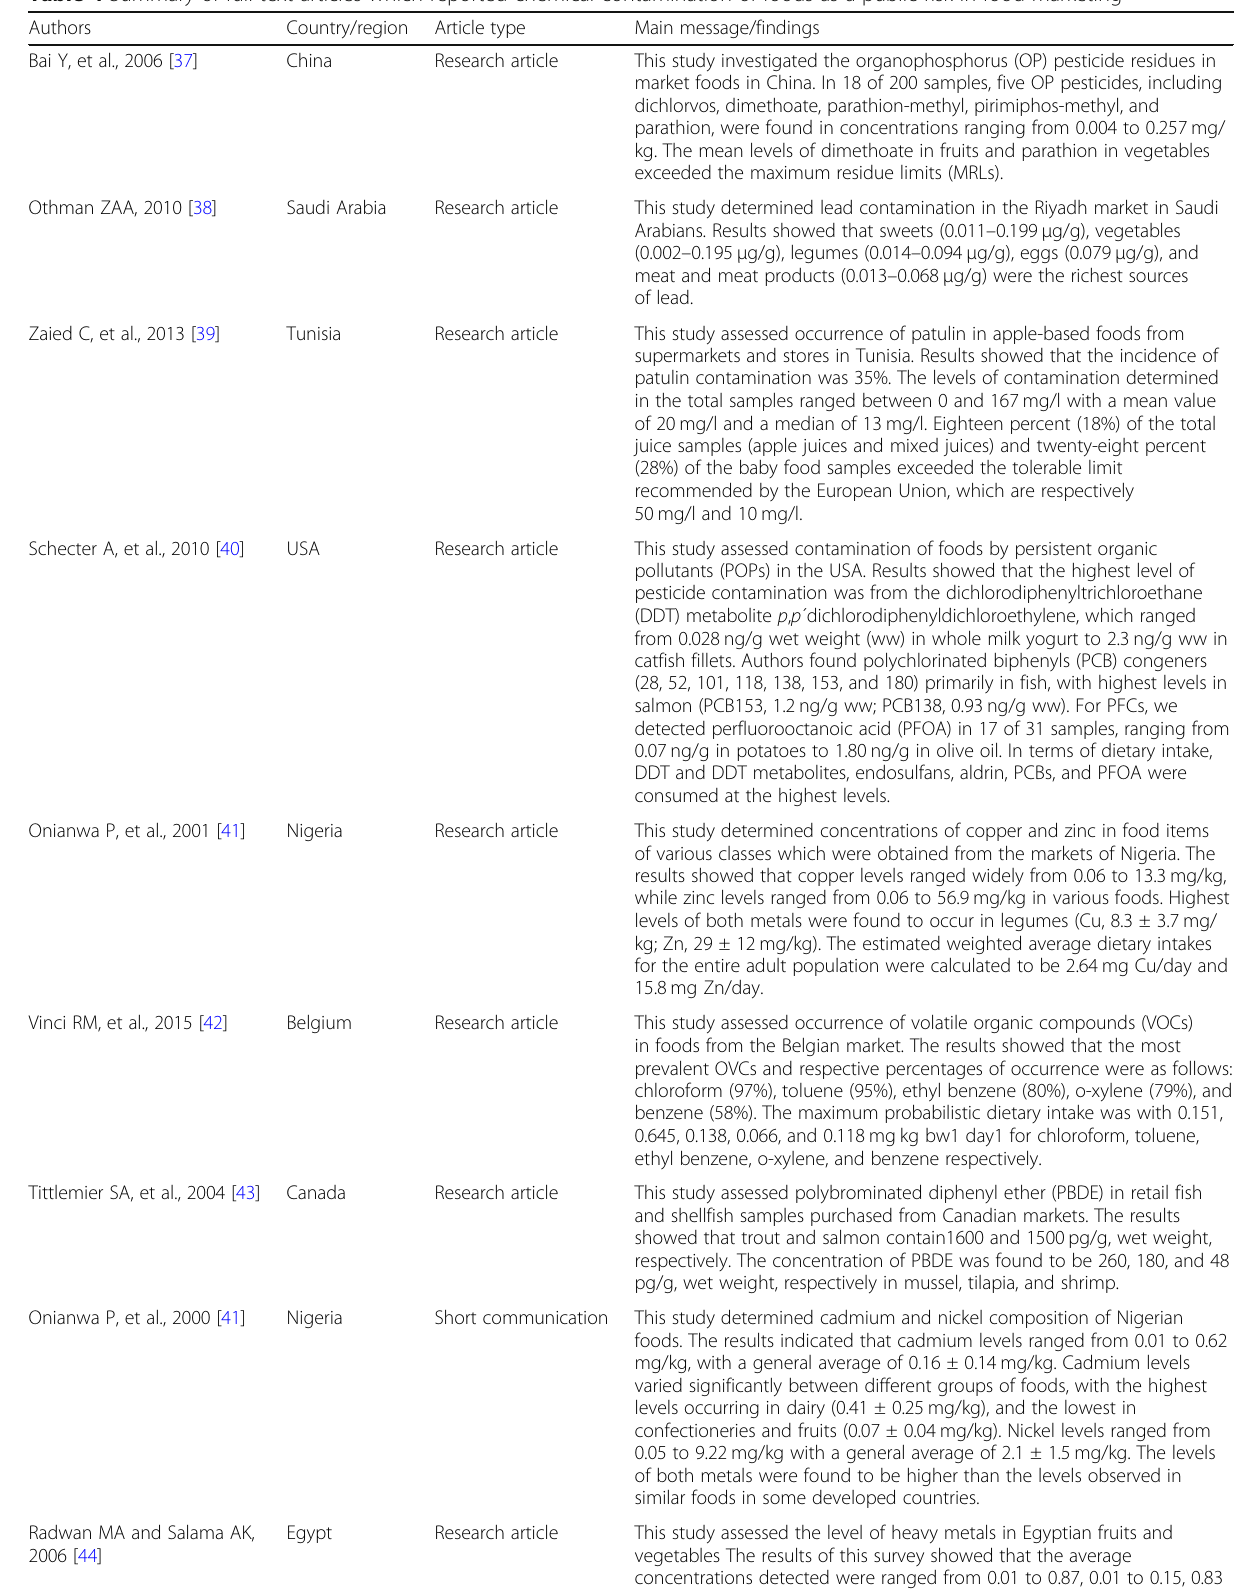
Table 4 Summary of full-text articles which reported chemical contamination of foods as a public risk in food